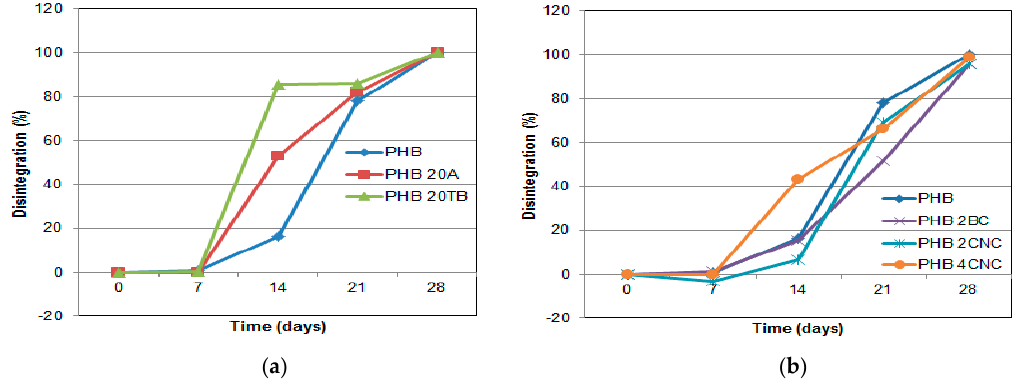
Figure 10. Disintegrability of plasticized PHB- ( a ) and cellulose-based nanocomposites ( b ).